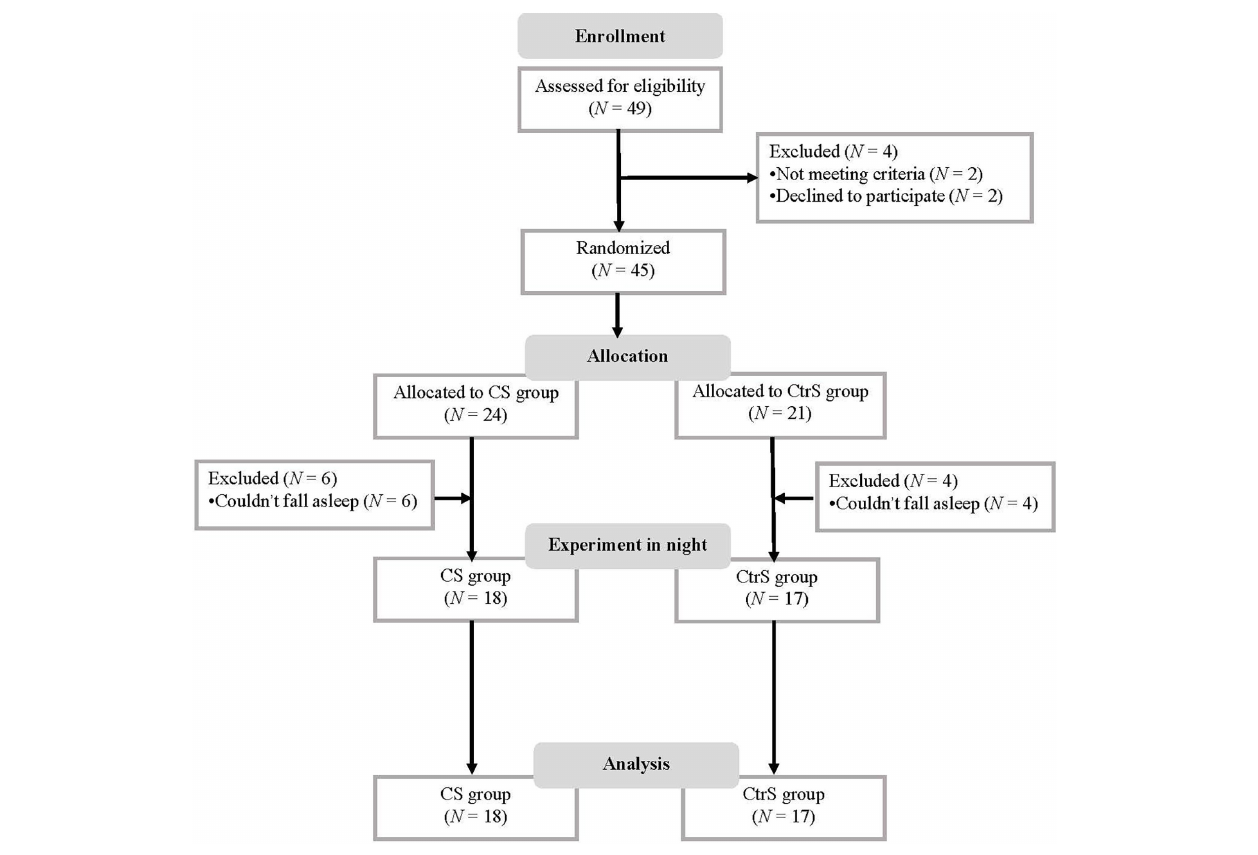
FIGURE 1 | Flow diagram. CS group, patients was re-exposed to olfactory alcohol cues; CtrS group, patients was re-exposed to water as an olfactory control.